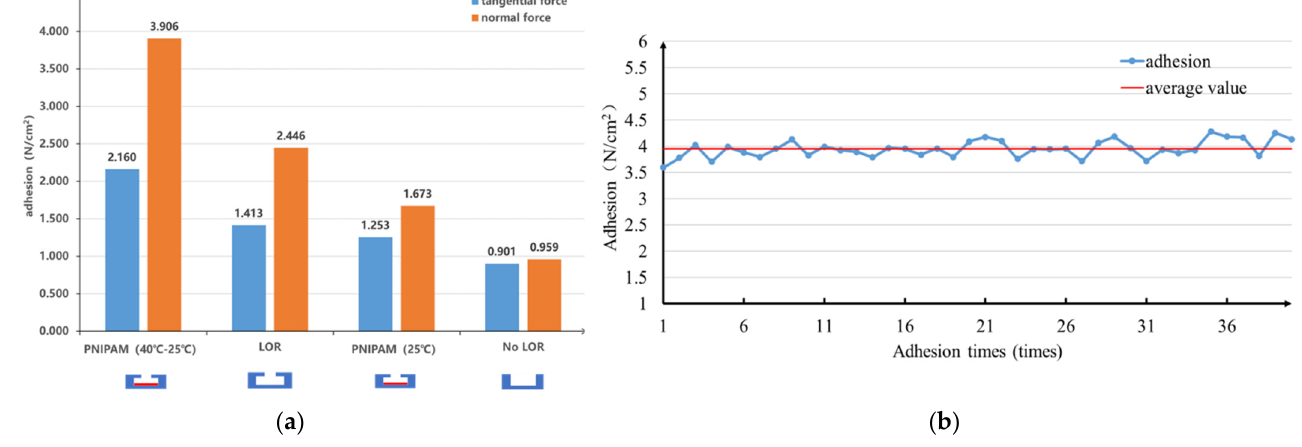
Figure 3. Test results of adhesive property of the biomimetic octopus sucker structure: ( a ) The normal force and tangential force of the four groups; ( b ) Repeated adhesion.